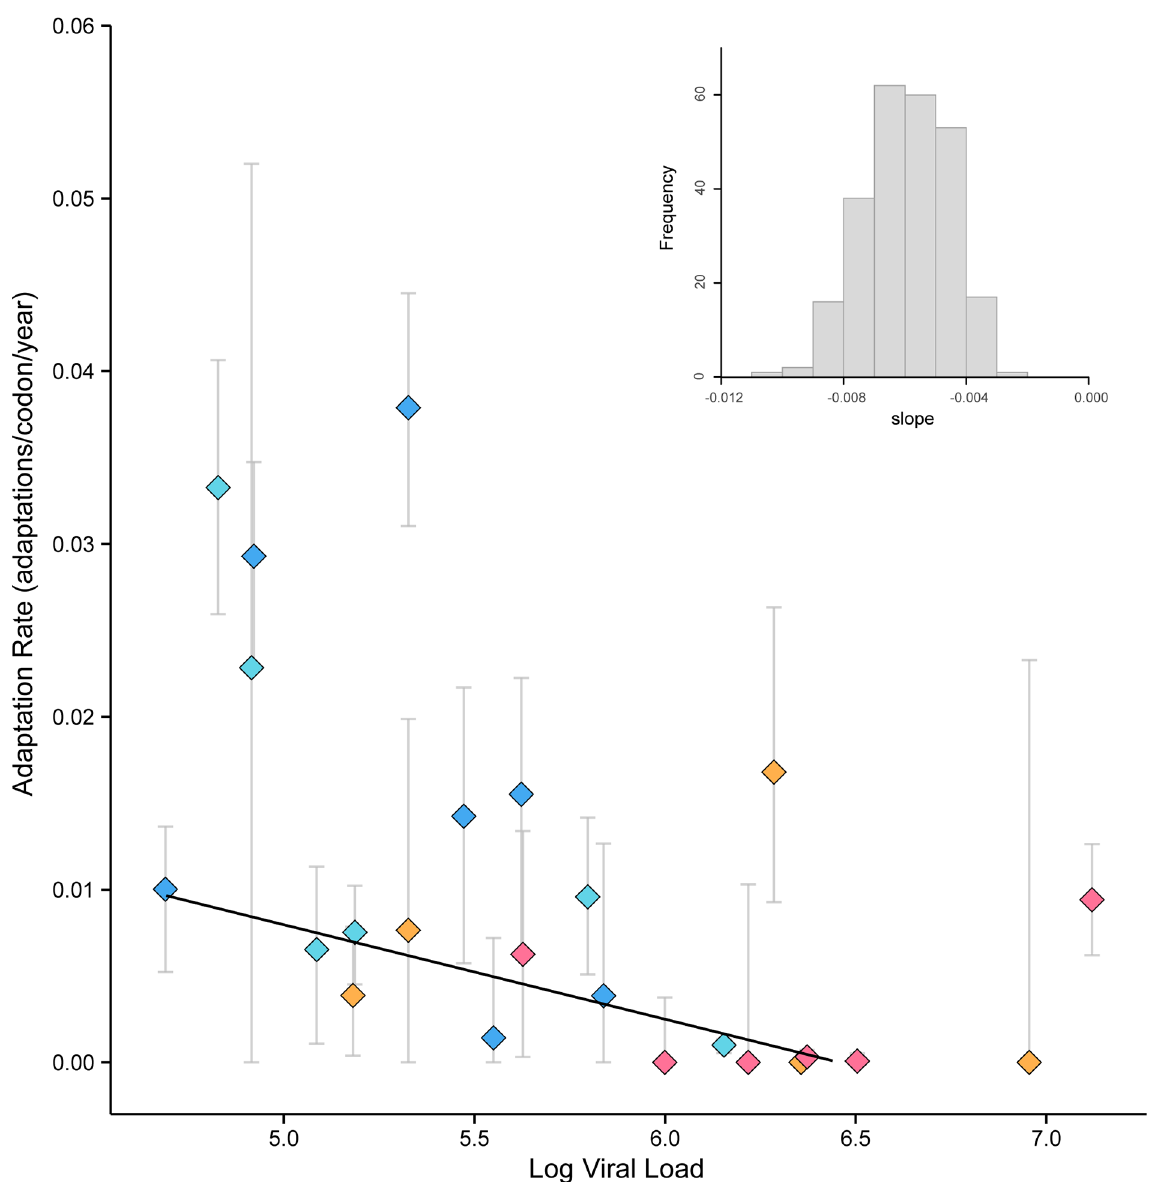
Fig 2. Viral adaptation rate is negatively correlated with viral population size in 24 pediatric HIV infections (Spearman ’ s rank correlation: p < 0.01). The trend-line was estimated using a weighted regression analysis (weighted regression: b = -0.0054, p < 0.01). The inset illustrates the bootstrap distribution of the slope, estimated from weighted regression, which indicates that the slope is less than zero. Data points are labeled by color according to the disease progression category of each patient as follows: slow non-progressors (SNP, dark blue), moderate non-progressors (MNP, light blue), moderate progressors (MP, orange), and rapid progressors (RP, pink). Error bars representing the uncertainty in our estimate were obtained using the bootstrap procedure described in [25]. Specifically, the error bars depict the lower and upper quartile estimates from 250 bootstrap samples.